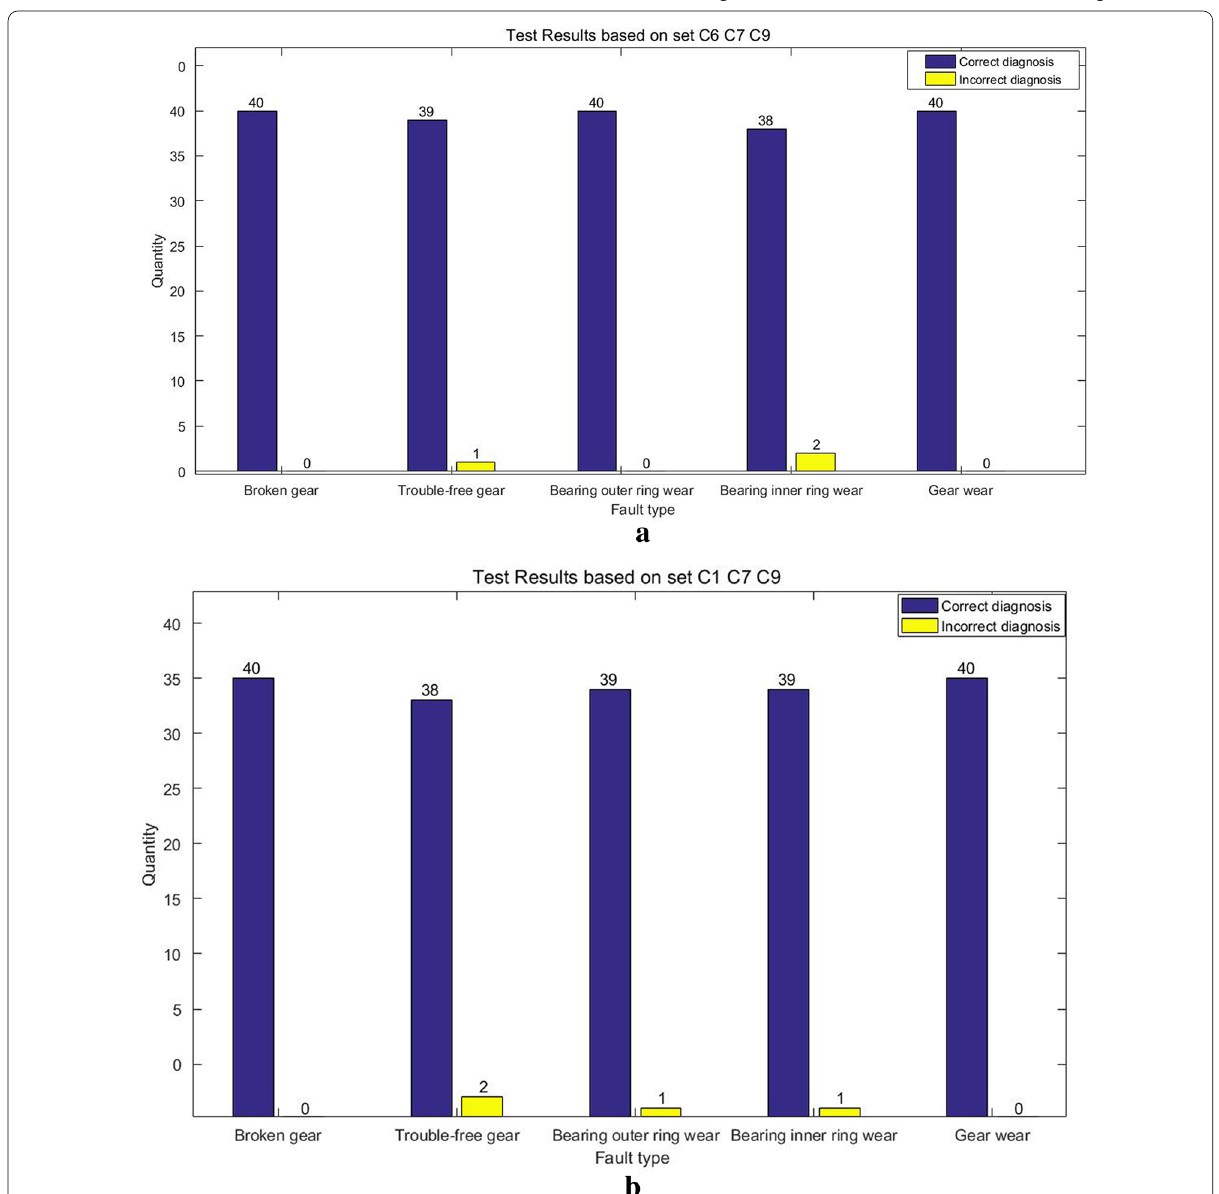
Figure 8 a Test results based on set {C6 C7 C9} attribute set. b Test results based on set{ C1 C7 C9} attribute